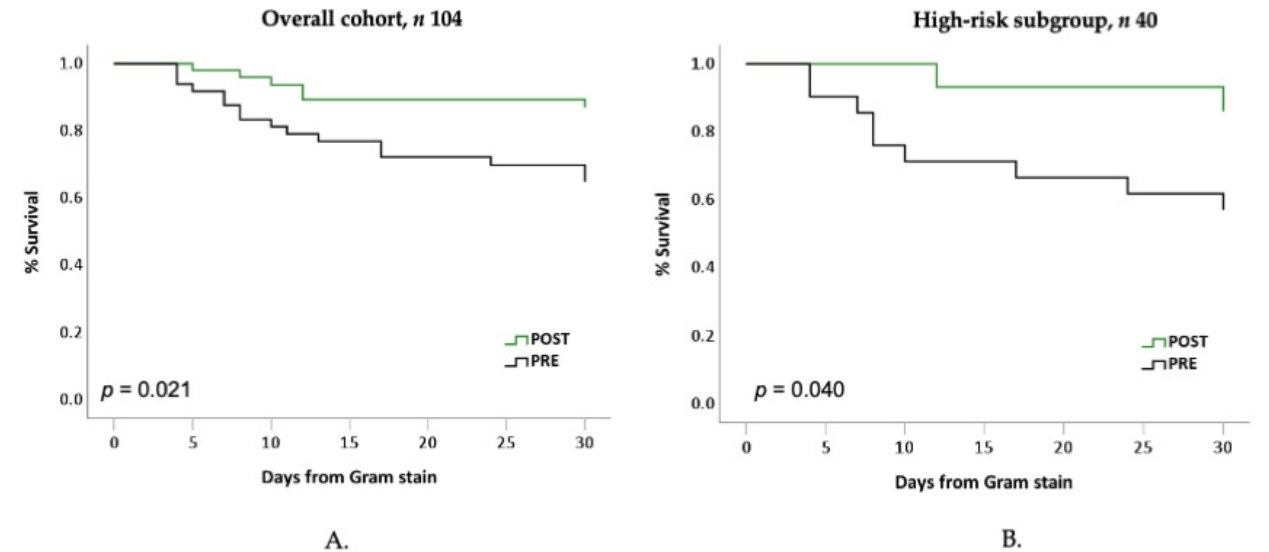
Figure 3. Adjusted odds ratio for in-hospital mortality during post-implementation vs. pre- implementation by subgroup. Kaplan–Meier (KM) plots depicting 30-day mortality hazards from time of Gram-stain stratified by implementation group in the ( A ) overall cohort and ( B ) high-risk subgroup comprising hematopoietic stem cell transplantation (HSCT), neutropenia (absolute neutrophil count [ANC] < 500 cells/mm 3 ), active hematological malignancies, and solid organ transplant recipients. p by log-rank test. Black line, pre-implementation group; green line, post-implementation group.